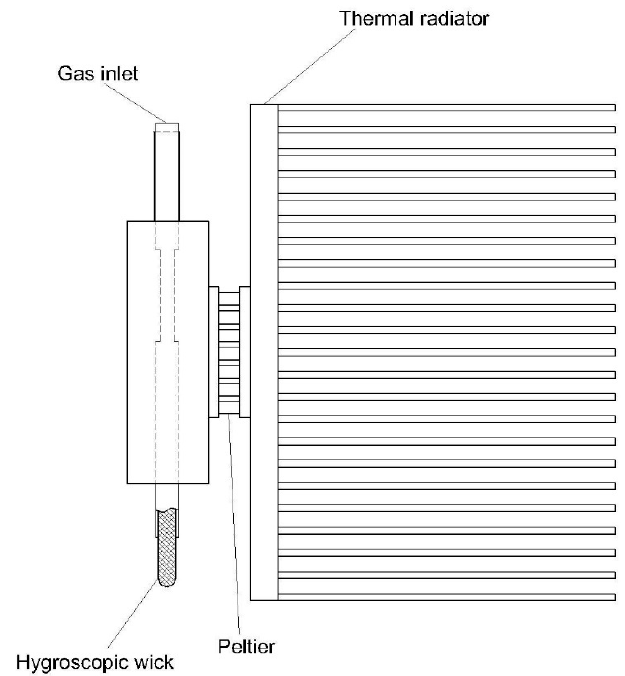
Figure 4. The embodiment of a heat exchanger using a Peltier [68].